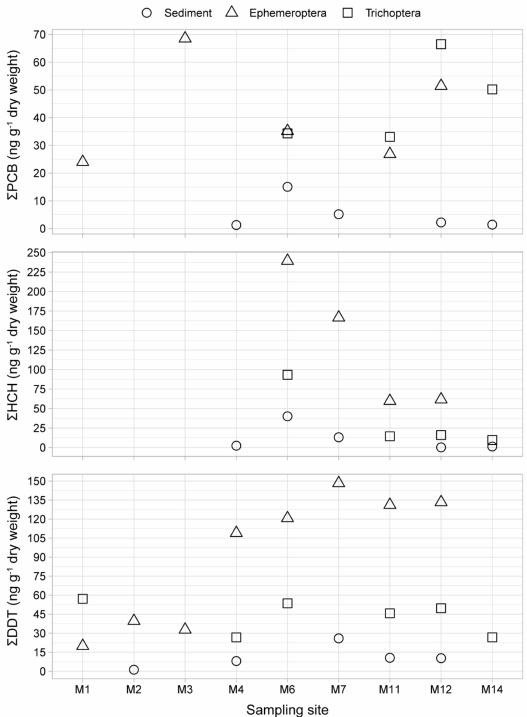
Figure 2. Concentration of Σ PCB, Σ HCH, and Σ DDT in sediment ( Trichoptera ( (cid:3) ) samples from the investigated sites.